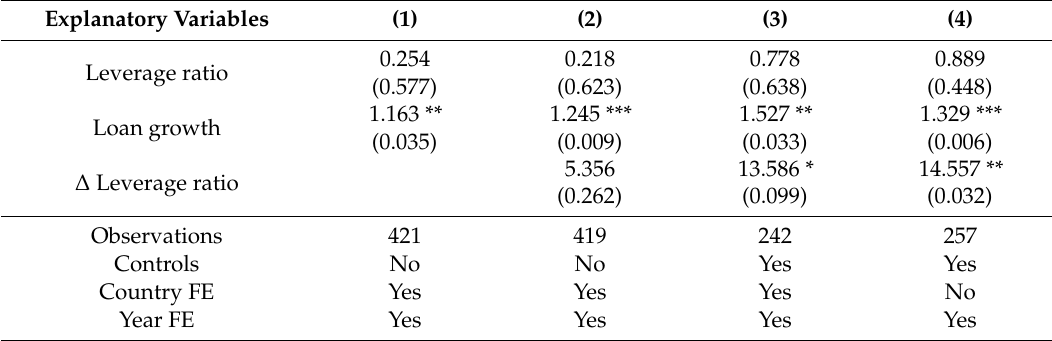
Table A1. E ff ect of bank capital on the probability of a banking